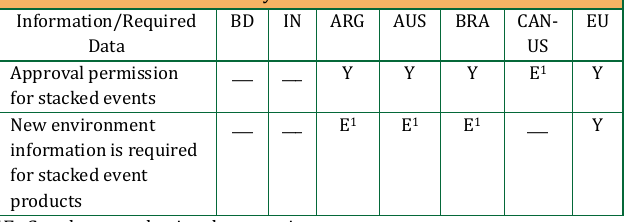
Table 10: Needful data analysis on the treatment of stacked events